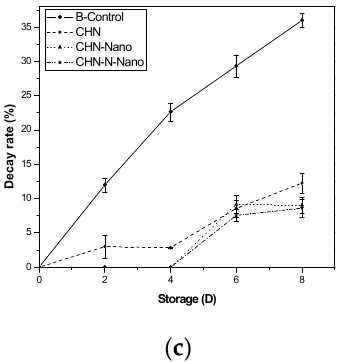
Figure 3. Effects of coating treatments on weight loss ( a ) and ( b,c ) shrinking and decay rates.